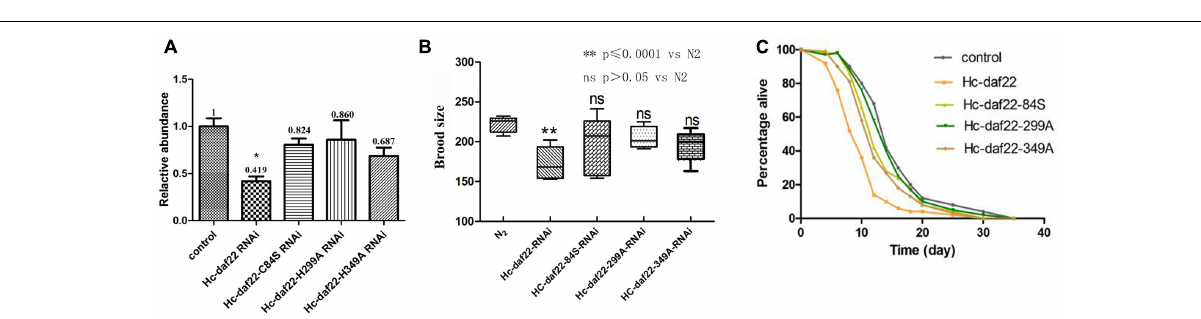
FIGURE 5 | Statistical analysis of brood size and body length of the strains in the rescue experiment, N 2 strain and ok693 were used as controls. (A) Brood size analysis. Compared to ok693 strain, Hc-daf-22 rescued worms showed significant increase in the number of descendant ( P ≤ 0.0001) but did not reach the level of N 2 strain, while the other three groups had no significant changes ( P > 0.05). (B) Body length analysis. Hc-daf-22 transformed worms were significantly longer than ok693 , while the other three groups had no significant changes which were similar with brood size analysis.